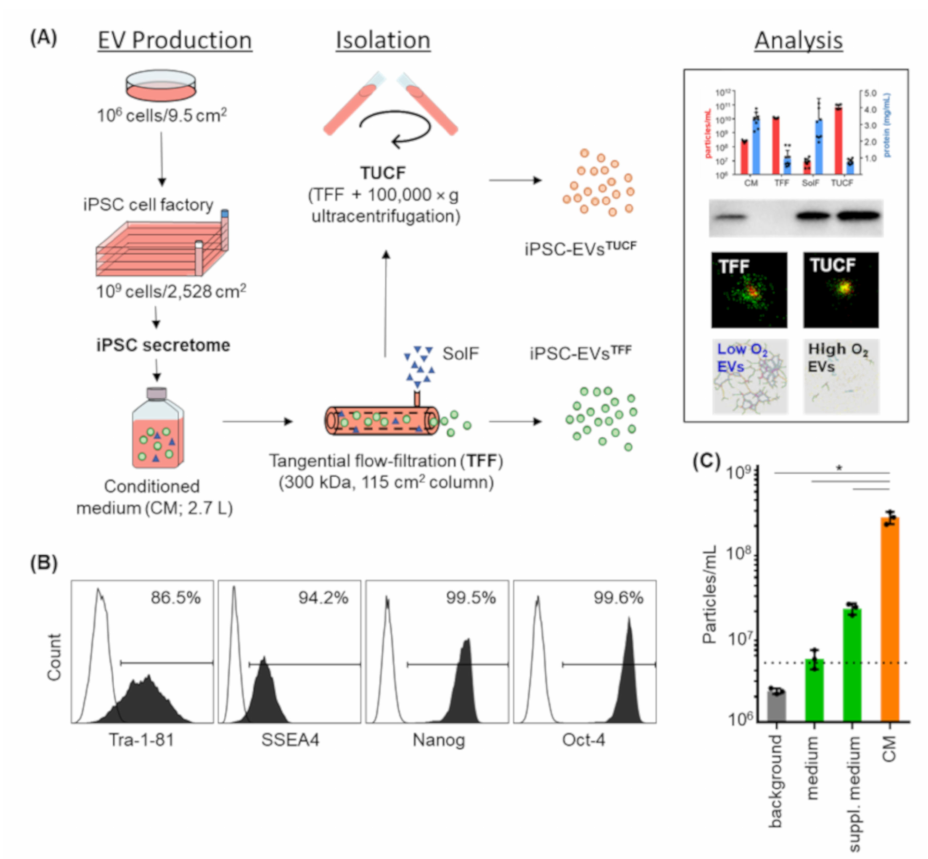
Figure 1. Large-scale production of induced pluripotent stem cell-derived extracellular vesicles (iPSC-EVs). ( A ) Schematic representation of large-scale EV production from iPSCs. After culture in six-well plates, iPSCs were transferred directly to T225 flasks and then to four-layered cell factories. Culture-conditioned medium (CM) was pooled and separated into soluble factors (SolF) and enriched EVs by tangential flow filtration (TFF). For further concentration and protein depletion, TFF-enriched EVs were submitted to ultracentrifugation (TUCF). Comparative EV analysis included particle, protein and EV identity determination as illustrated plus single EV phenotyping and function tests. ( B ) Identity and purity of human iPSCs determined by Tra-1-81, SSEA-4, Nanog, OCT-4 flow cytometry (representative data shown). ( C ) Particle concentration during EV production measured by tunable resistive pulse sensing (TRPS) in background (PBS + 0.05% Tween 20, 0.22 µ m pore filtered), basic and supplemented defined serum-free medium (mTeSR™1) before and after culturing cells. Mean ± SEM of three independent experiments; individual results for CM are shown in Figure 2A. Dotted line represents limit of detection. Mean ± SD of three measurements (* p <